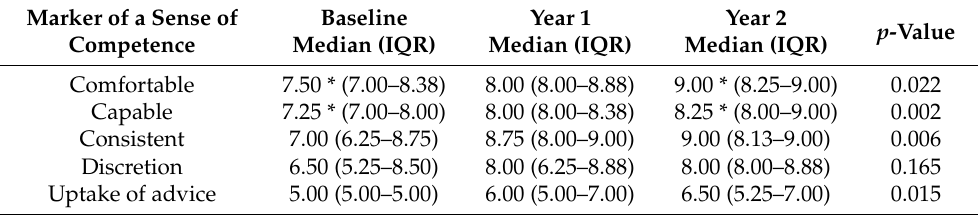
Table 1. Median and interquartile range (IQR) of the reported qualifiers associated with giving biosecurity advice to the